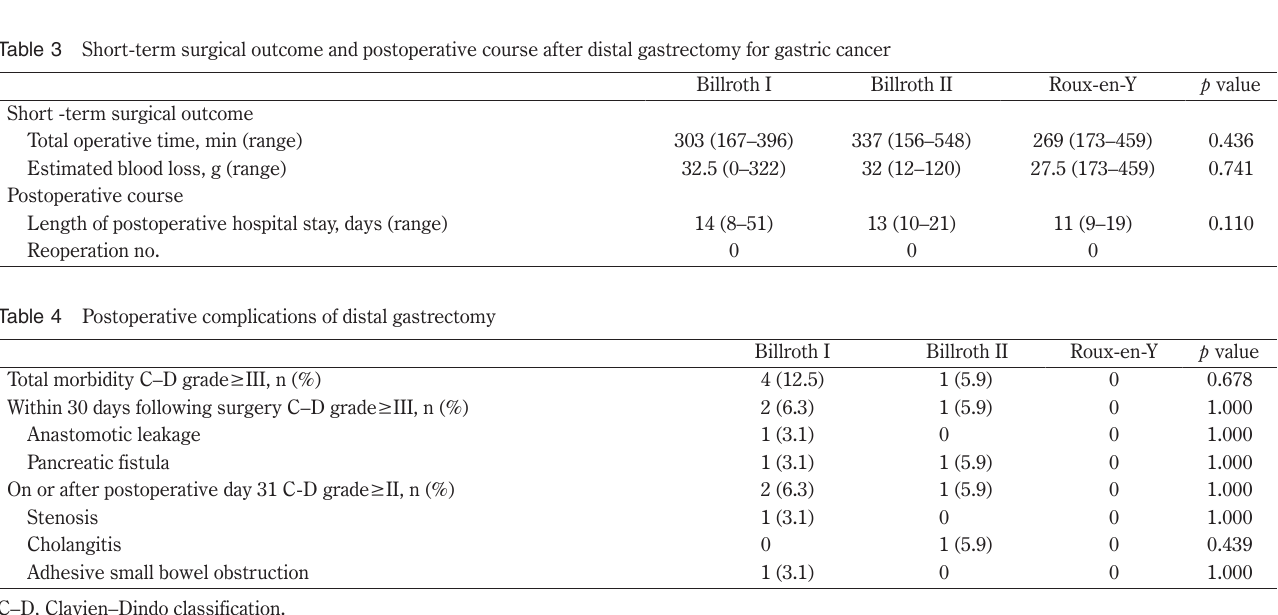
Table 3 Short-term surgical outcome and postoperative course after distal gastrectomy for gastric cancer